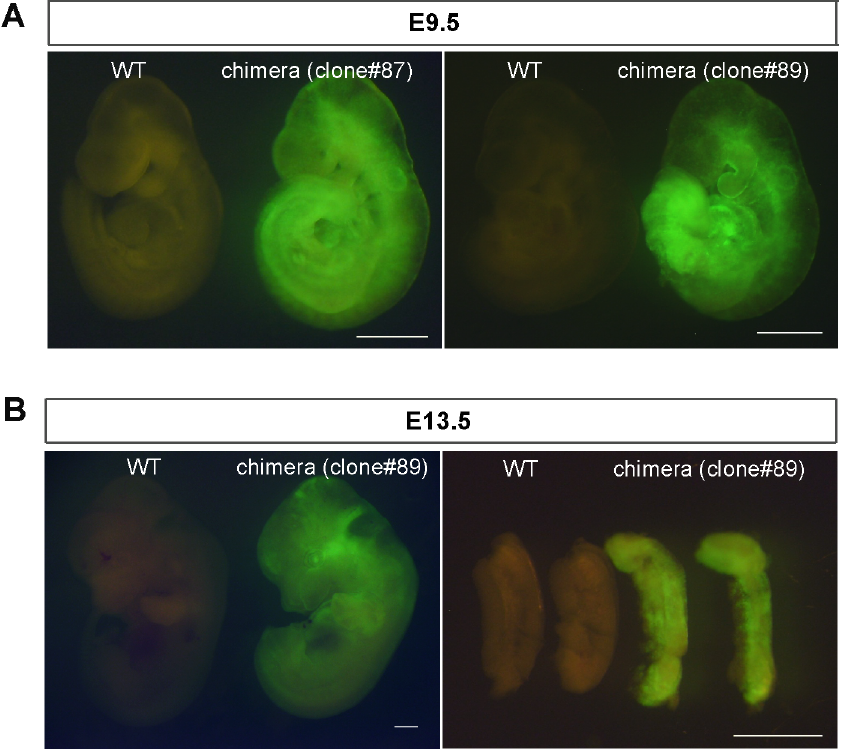
Fig 5. Chimera formation with iPSCs reprogrammed from EpiSCs. (A) Chimeras at E9.5 generated from two independent iPSC lines (#87 and 89). (B) Chimera and its genital ridge at E13.5 generated from iPSC line #89. Scale bar: 1